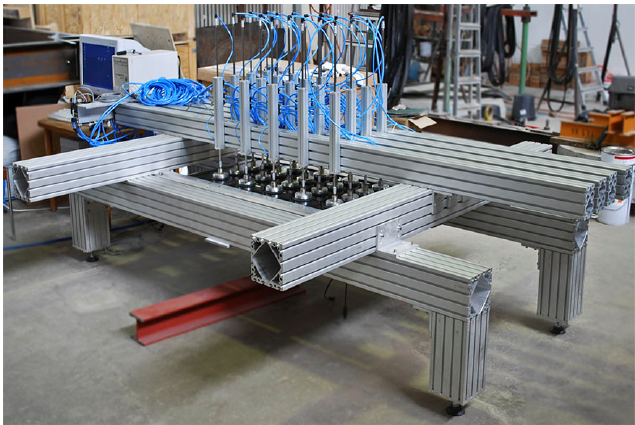
Figure 4: Pneumatic testing